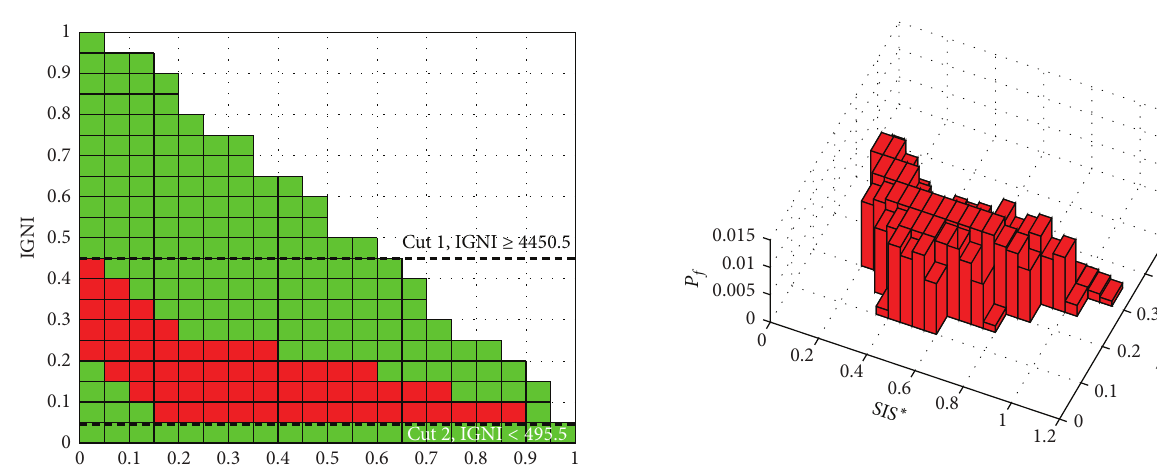
Figure 7: Containment failure probability distribution for sequence [ INI SIS IGNI ] .